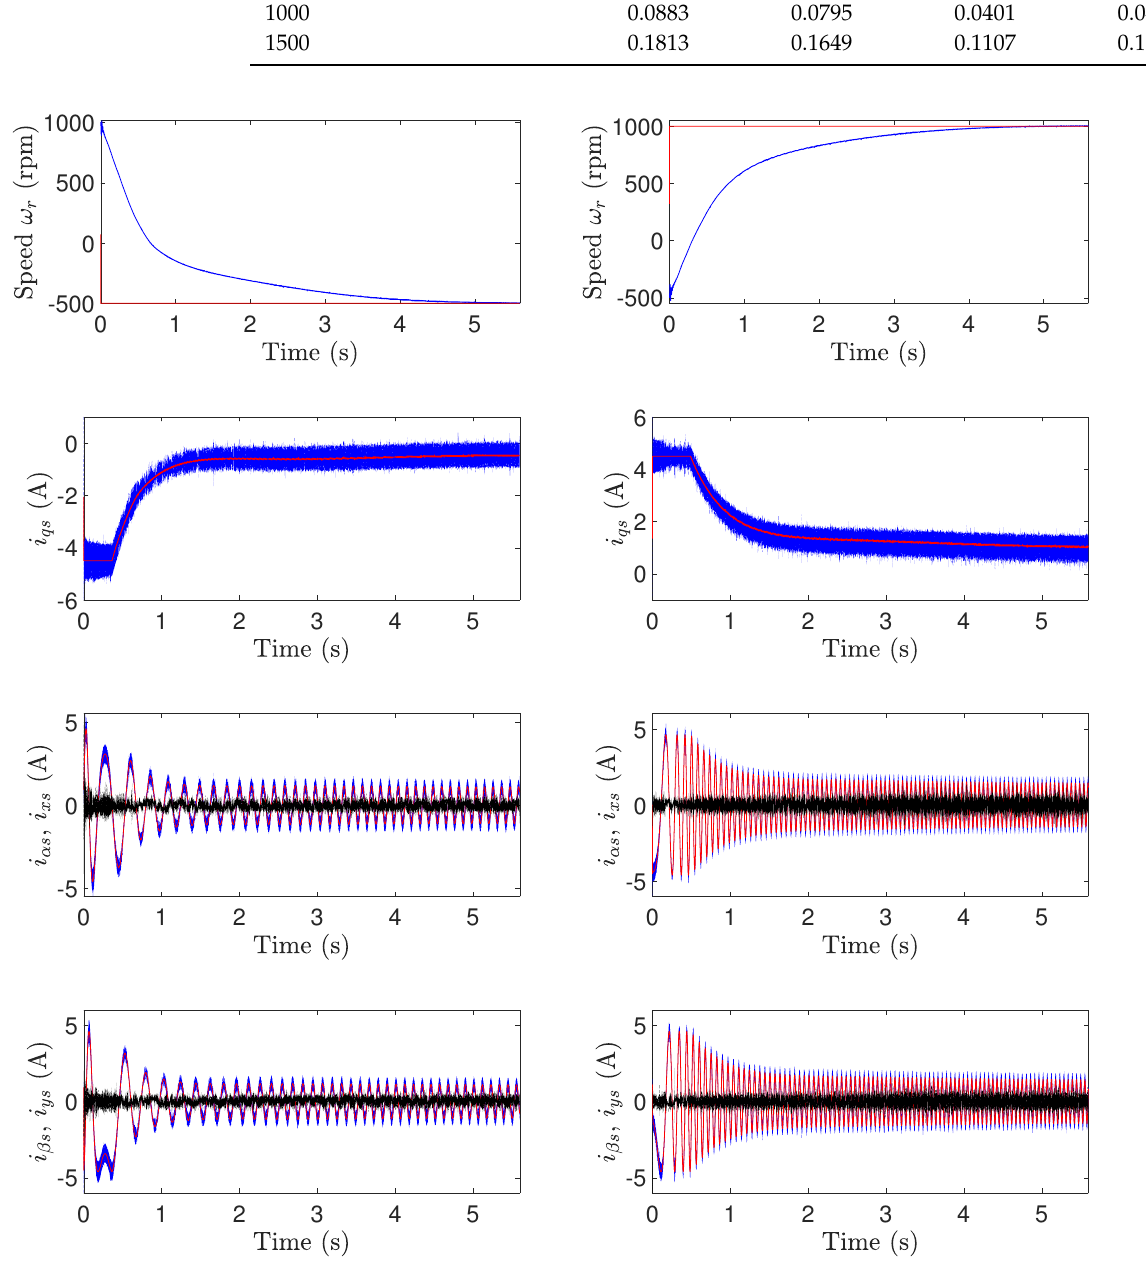
Figure 5. Transient response of { q , α , x , β , y } stator currents for two different desired step rotor speeds ω d r : results from 1000 to − 500 rpm in the left column and from − 500 to 1000 rpm in the right